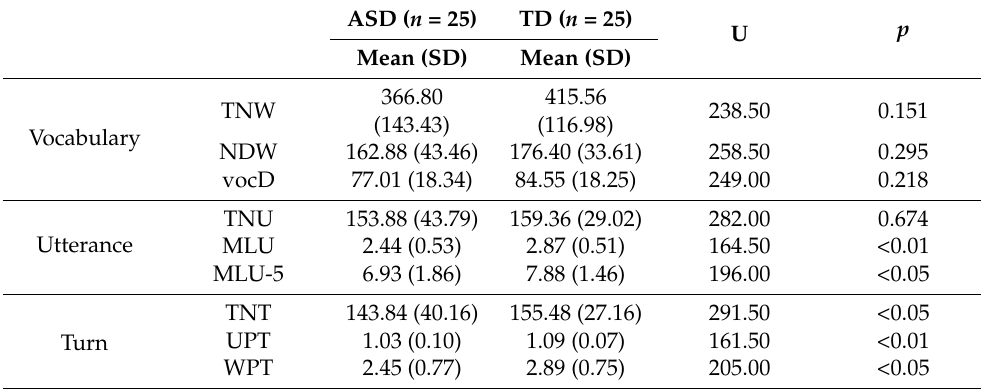
Table 2. Effects of the group (ASD/TD) on structural language and pragmatic skills in communicative interaction: descriptive statistics and results of Mann–Whitney U tests.